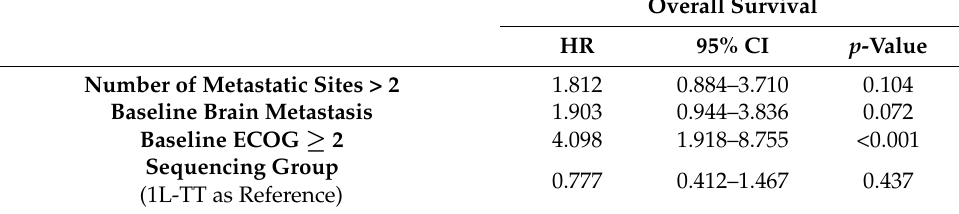
Table 3. Multivariable Cox analysis of study population.